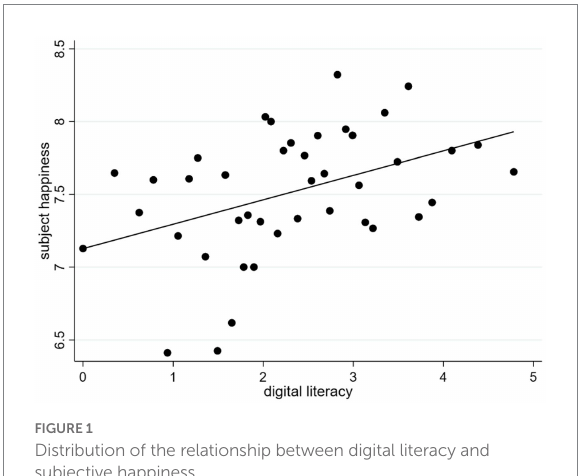
FIGURE 1 Distribution of the relationship between digital literacy and subjective happiness.